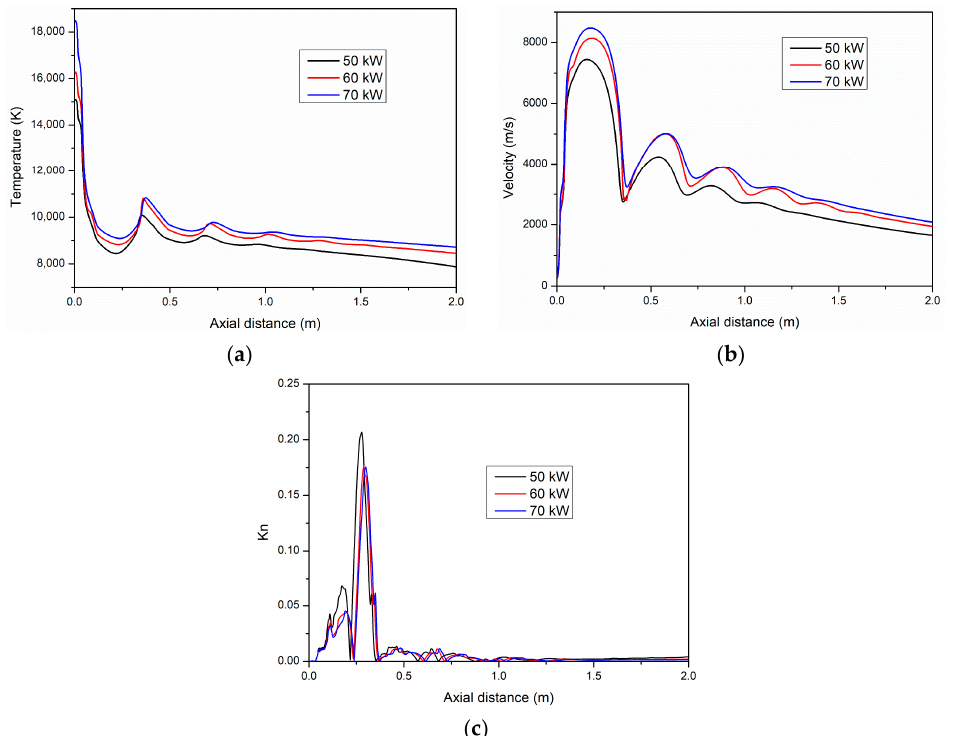
Figure 9. Variation of the 60Ar–30He plasma jet ( a ) temperature, ( b ) velocity, and ( c ) Knudsen number along the torch axis for different net powers at 100 Pa.